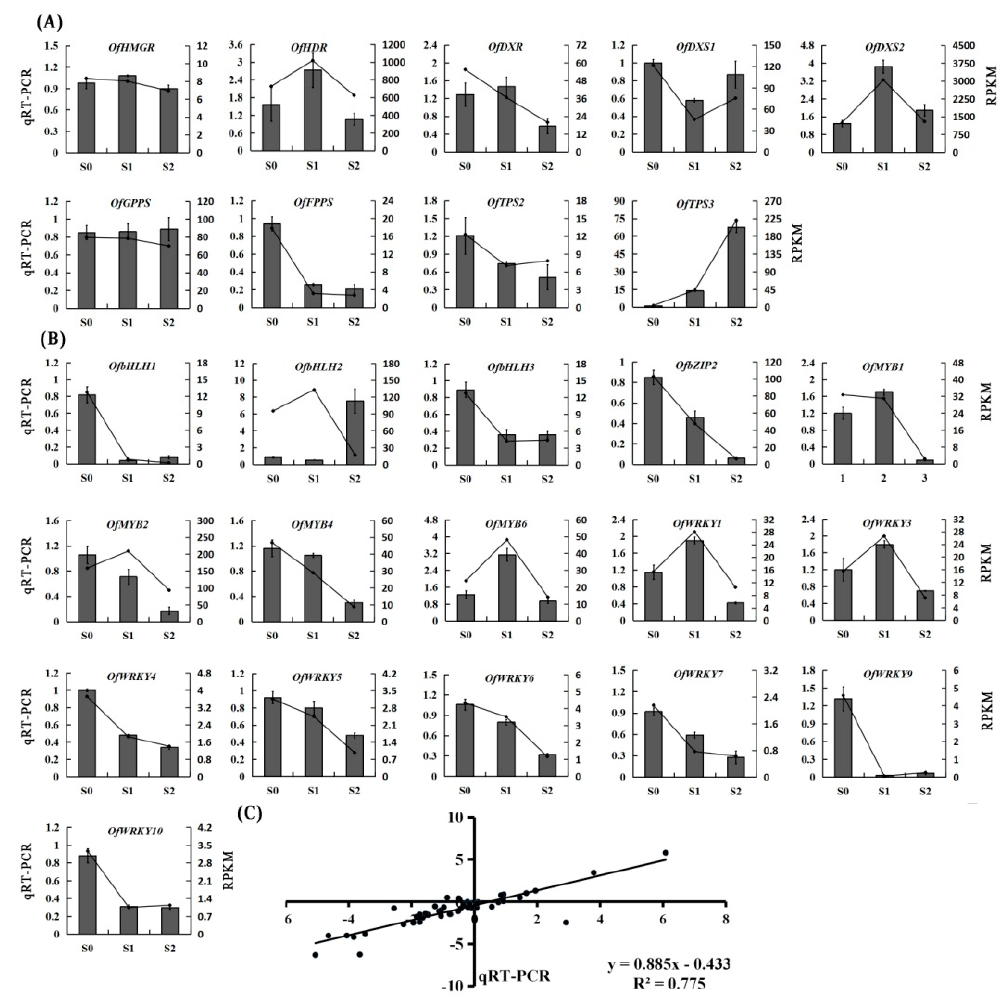
Figure 6. The qRT-PCR validation of DEGs. ( A ) Expression patterns of genes encoding enzymes possibly involved in terpenoid biosynthesis; ( B ) Expression analysis of TFs in different flowering stages. Relative transcription level of flowers was set to be 1 (100%). Error bars indicate the calculated maximum and minimum expression quantity of the three replicates. Different lowercase letters labeled on the bars indicate statistically significant differences at the level of p < 0.05. S1, initial flowering stage; S2, full flowering stage; S3, final flowering stage; ( C ) The correlation analysis of the gene expression ratios between qRT-PCR and RNA-seq.